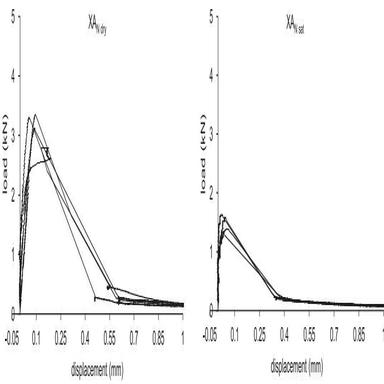
Flexural load–displacement diagrams of tested XA specimens: dry mass (left) and saturated (right) conditions.